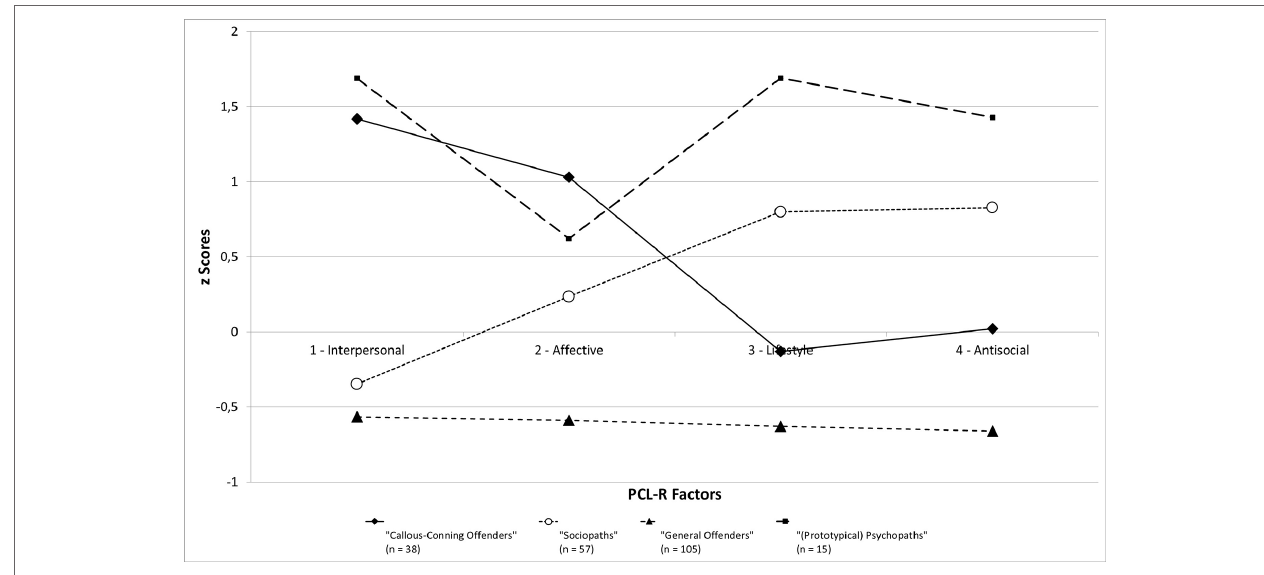
FIGURE 1 | Mean z-scores of each latent class on each PCL-R